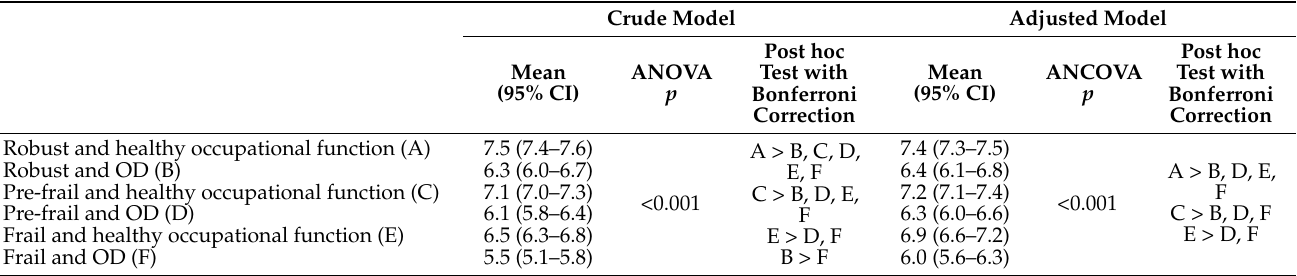
Table 2. With and without frailty/OD and subjective well-being.